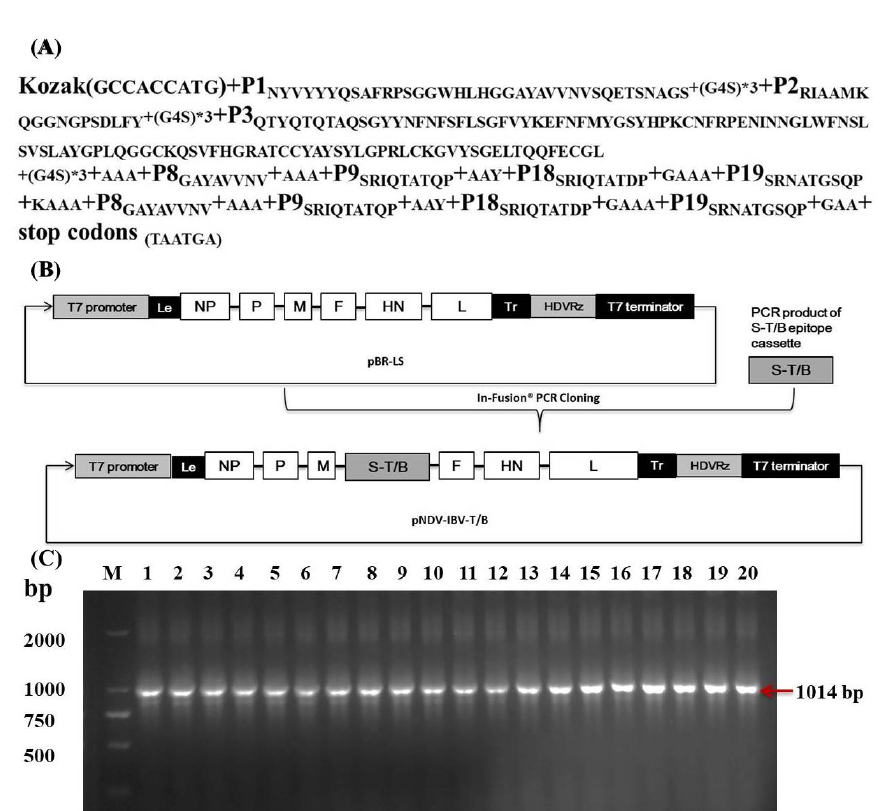
Figure 1. Scheme of rNDV-IBV-T/B construction. ( A ) The open reading frame (ORF) of the IBV S1 T/B multi-epitope cassette gene was amplified from the plasmid pV-S1B + S1T. The cassette contained multi-epitope cassette gene was amplified from the plasmid pV-S1B+S1T. The cassette contained the Kozak sequence, three neutralizing epitopes (P1–P3), four BF2-restricted T cell epitopes (P8, P9, P18, P19), and was linked with flexible amino acids. ( B ) The multi-epitope cassette ORF was inserted into